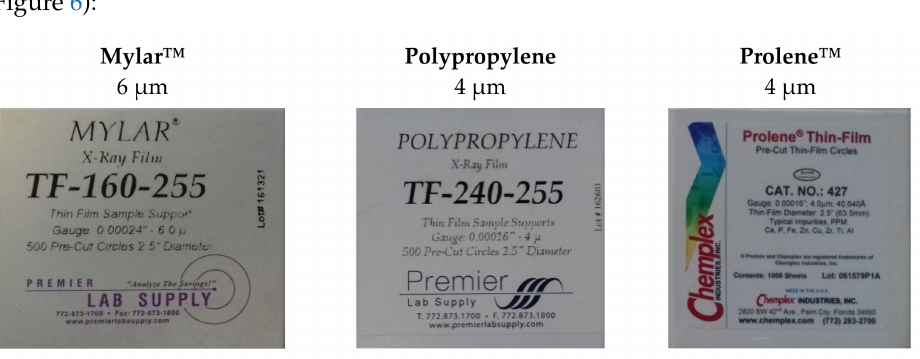
Figure 6. Different types of sample cup film. The most common types of films are addressed